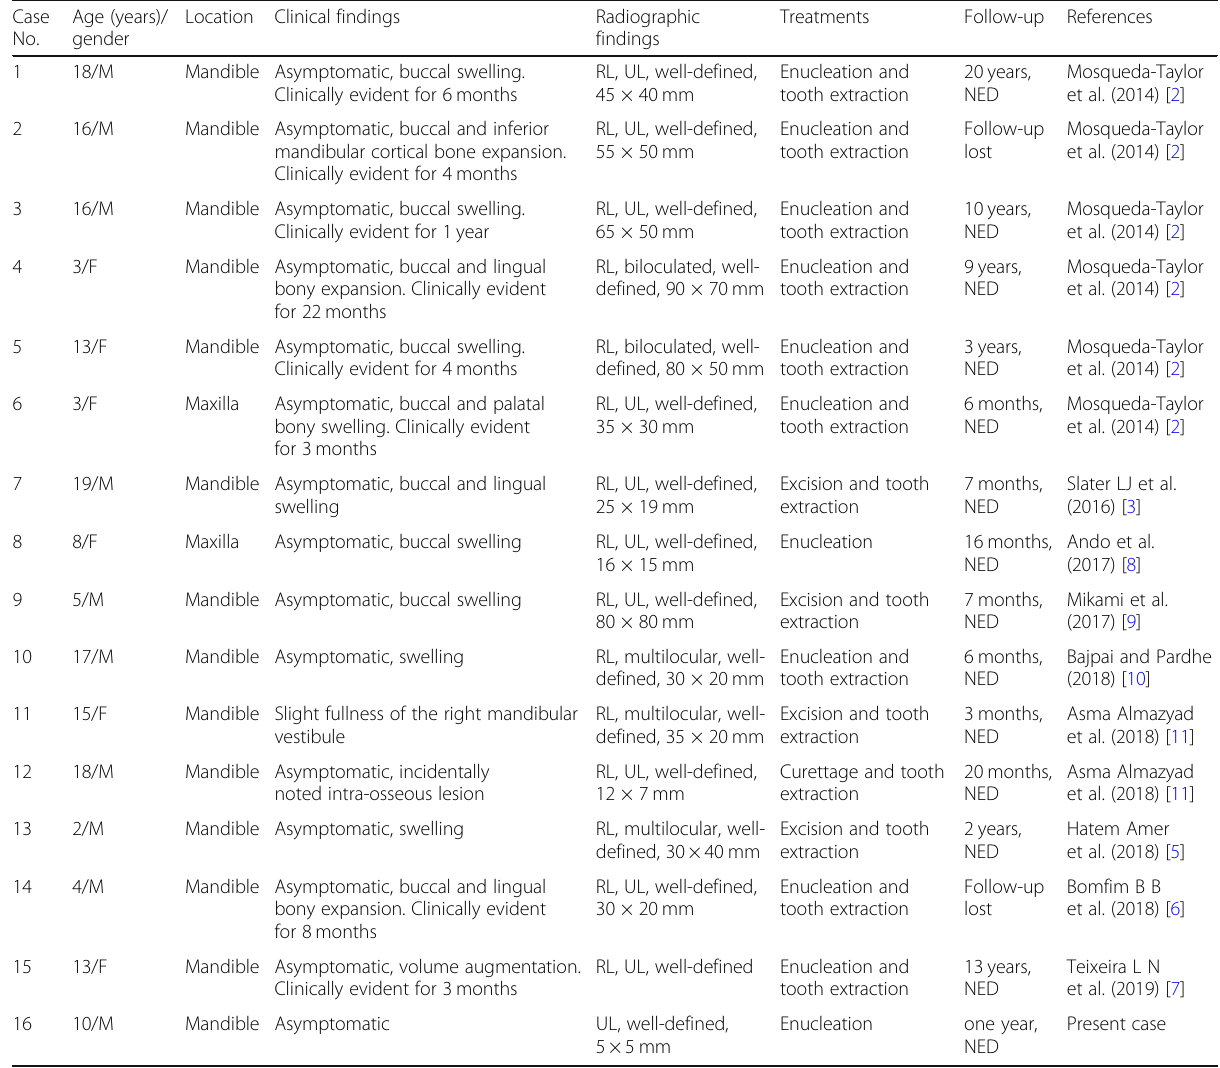
Table 1 Summary of previous and current reports of primordial odontogenic tumor Case